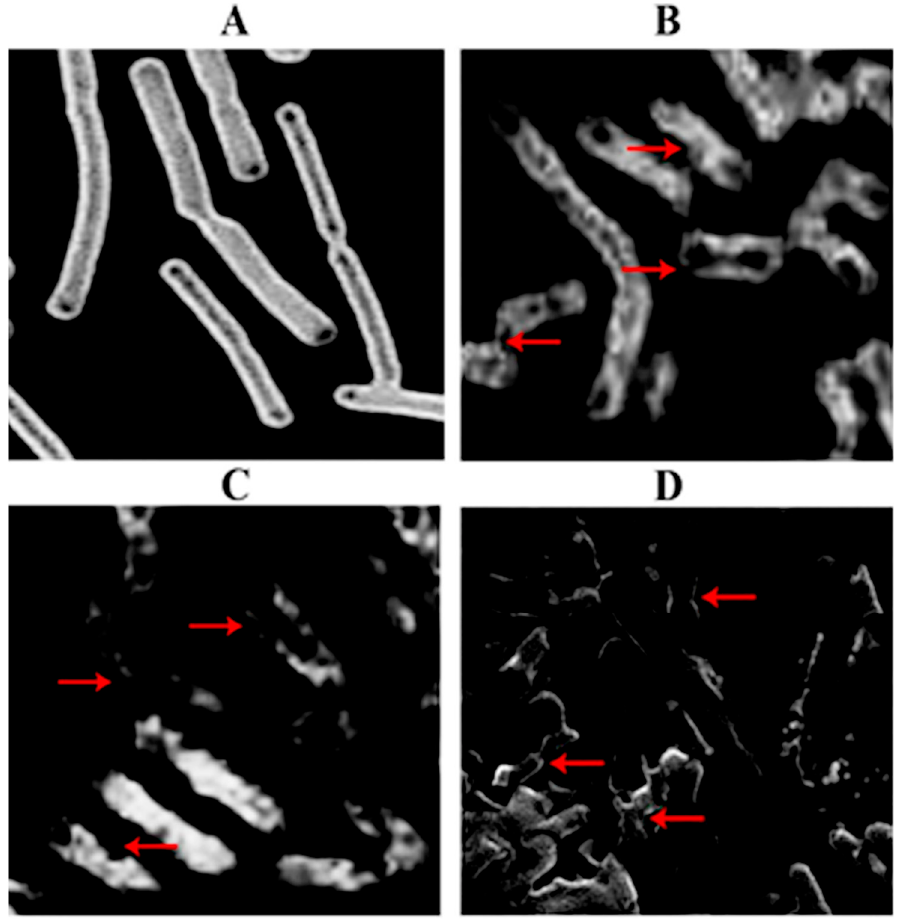
Figure 6. Morphological changes investigated by SEM of E. coli . ( A ) Non-treated E. coli , ( B ) E. coli treated with ZnO NPs, ( C ) E. coli treated with Au NPs, and ( D ) E. coli treated with Au/ZnO NCs. Red arrows showing bacterial membrane damage. Scale bar: 1 μ m.